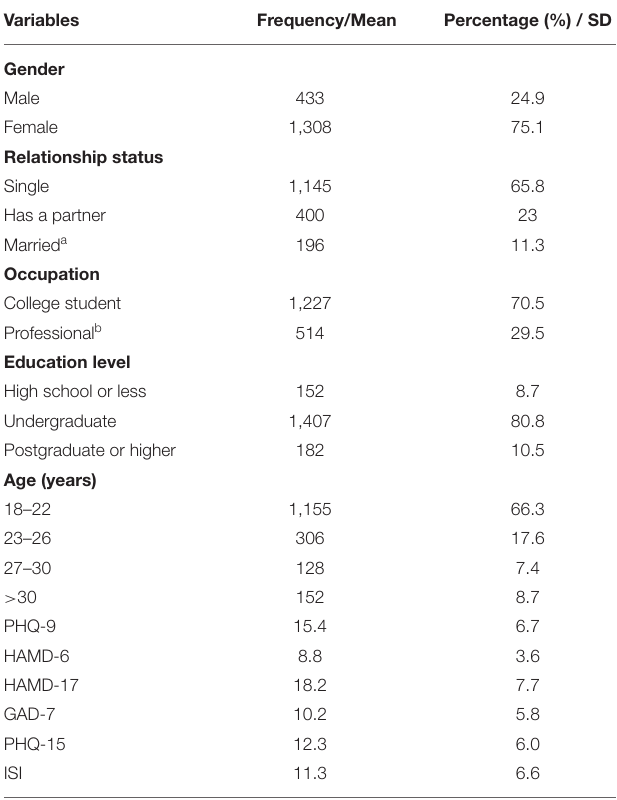
TABLE 1 | Socio-demographic characteristics of participants ( n =